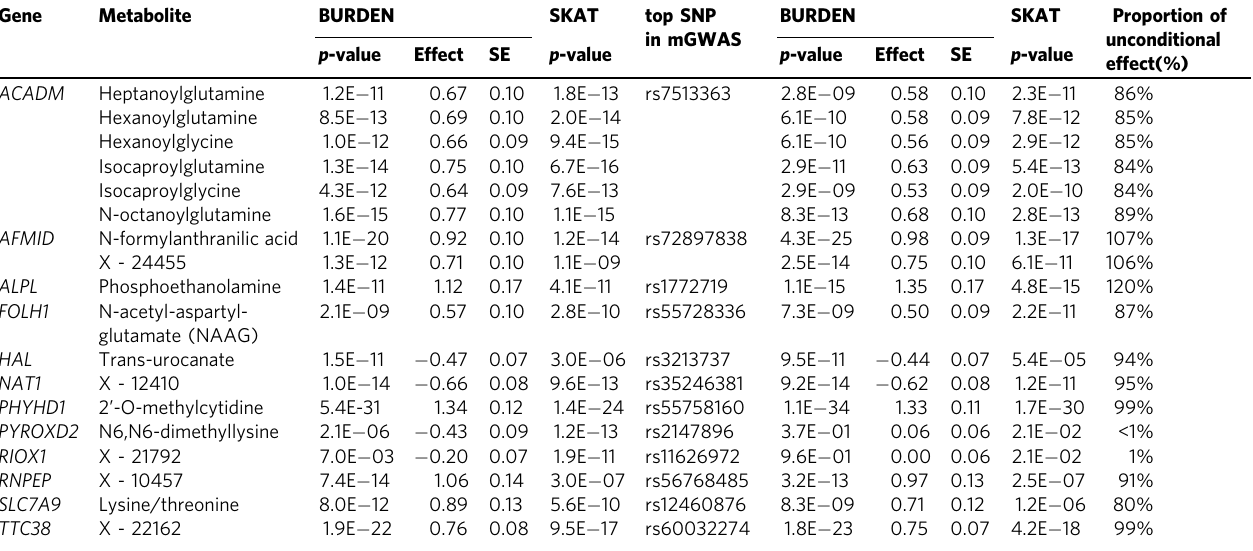
Table 3 Gene-based tests for signi fi cant metabolites before (left side) and after (right side) conditioning on common metabolite-associated variants in cis .